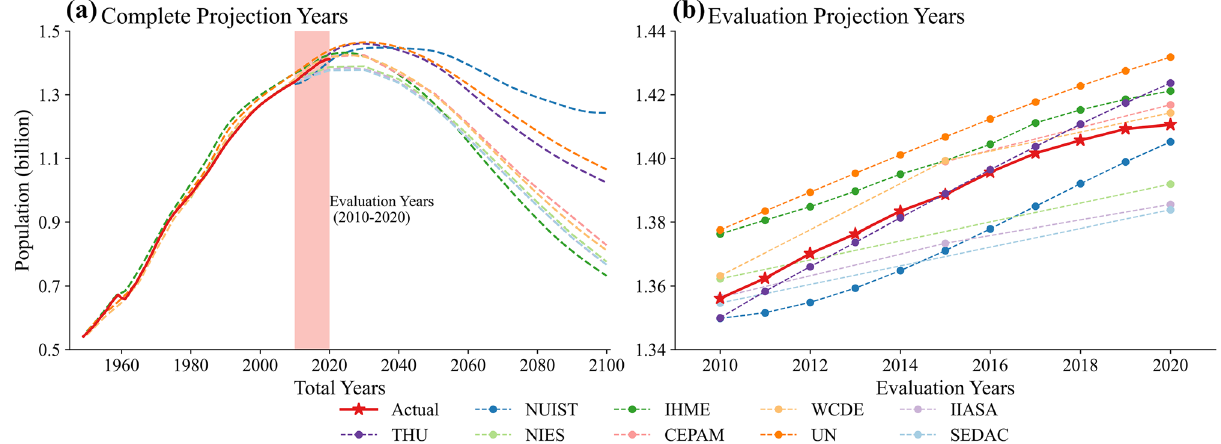
Figure 2. Comparison between the actual and projection population at the country scale. The vertical axis is the population number (unit: billion), and the horizontal axis represents the